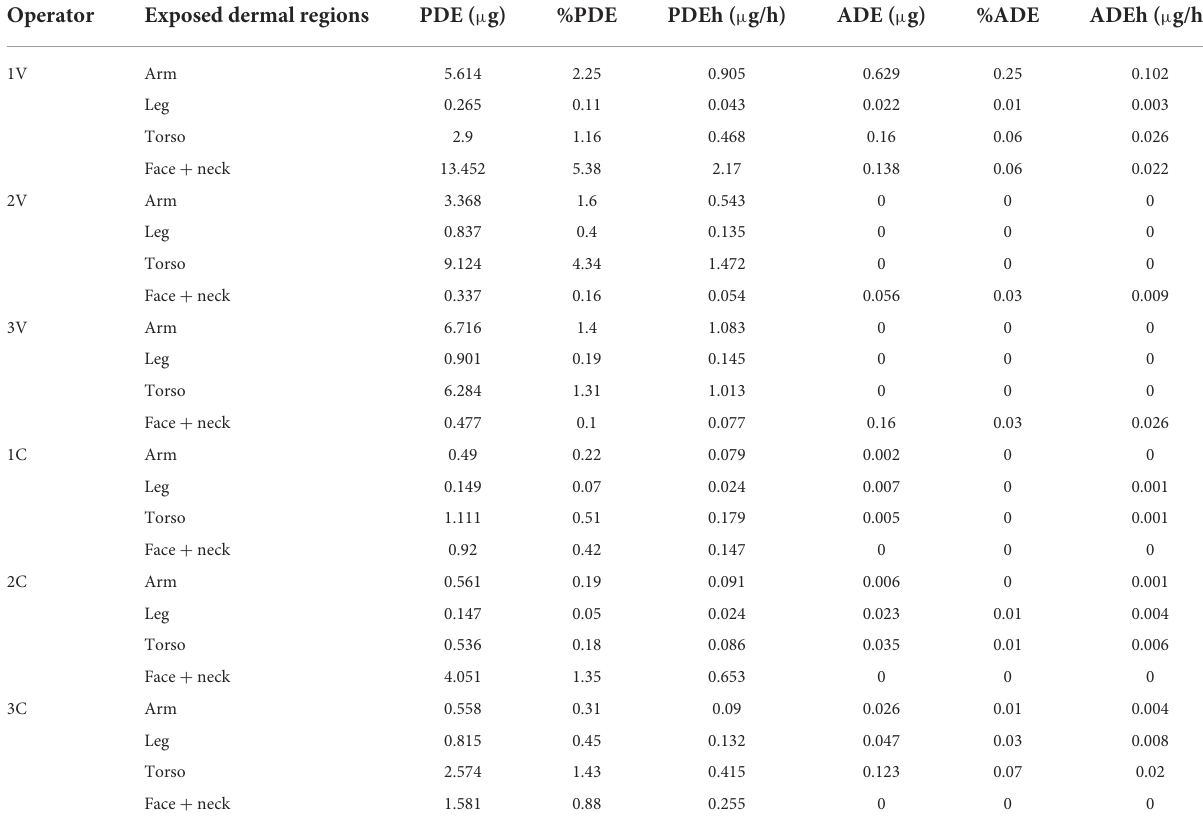
TABLE 7 Potential and actual dermal exposure (PDE and ADE, expressed in µ g), %PDE, %ADE and skin loading rates for all operators.